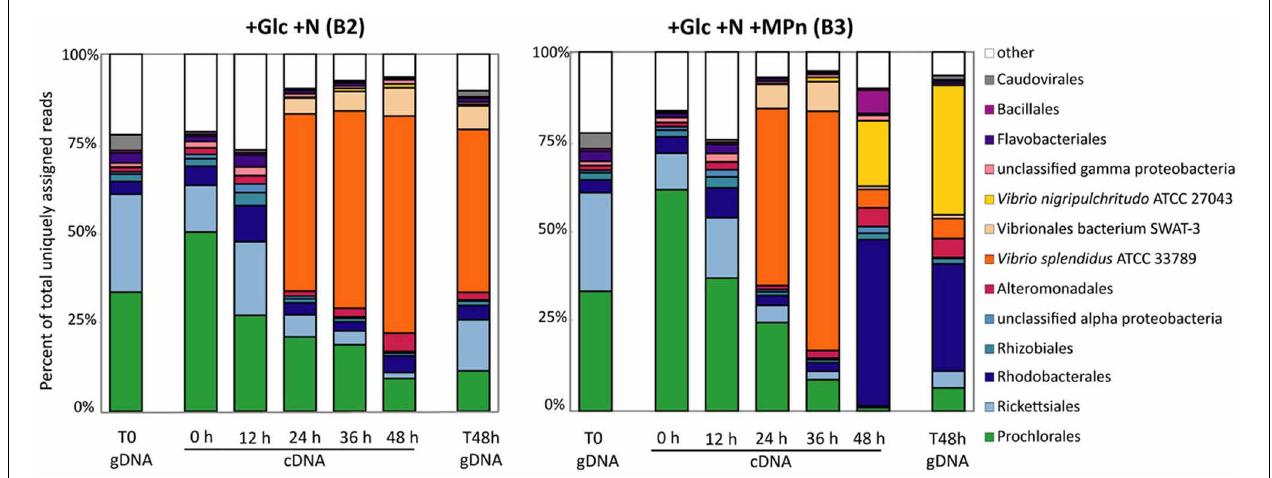
FIGURE 4 | Microbial population composition of amended microcosms assessed by taxonomic classification of protein-coding metatranscriptomic reads. Abundance expressed as the percentage of reads assigned to each taxon divided by the total number of non-rRNA, non-sRNA